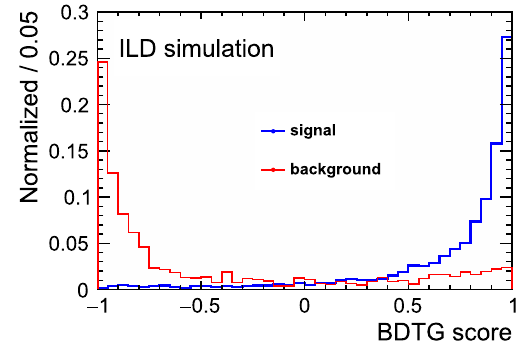
Fig. 6 The distribution of BDTG score (qqH250-L). Both histograms are normalised to an integral of 1